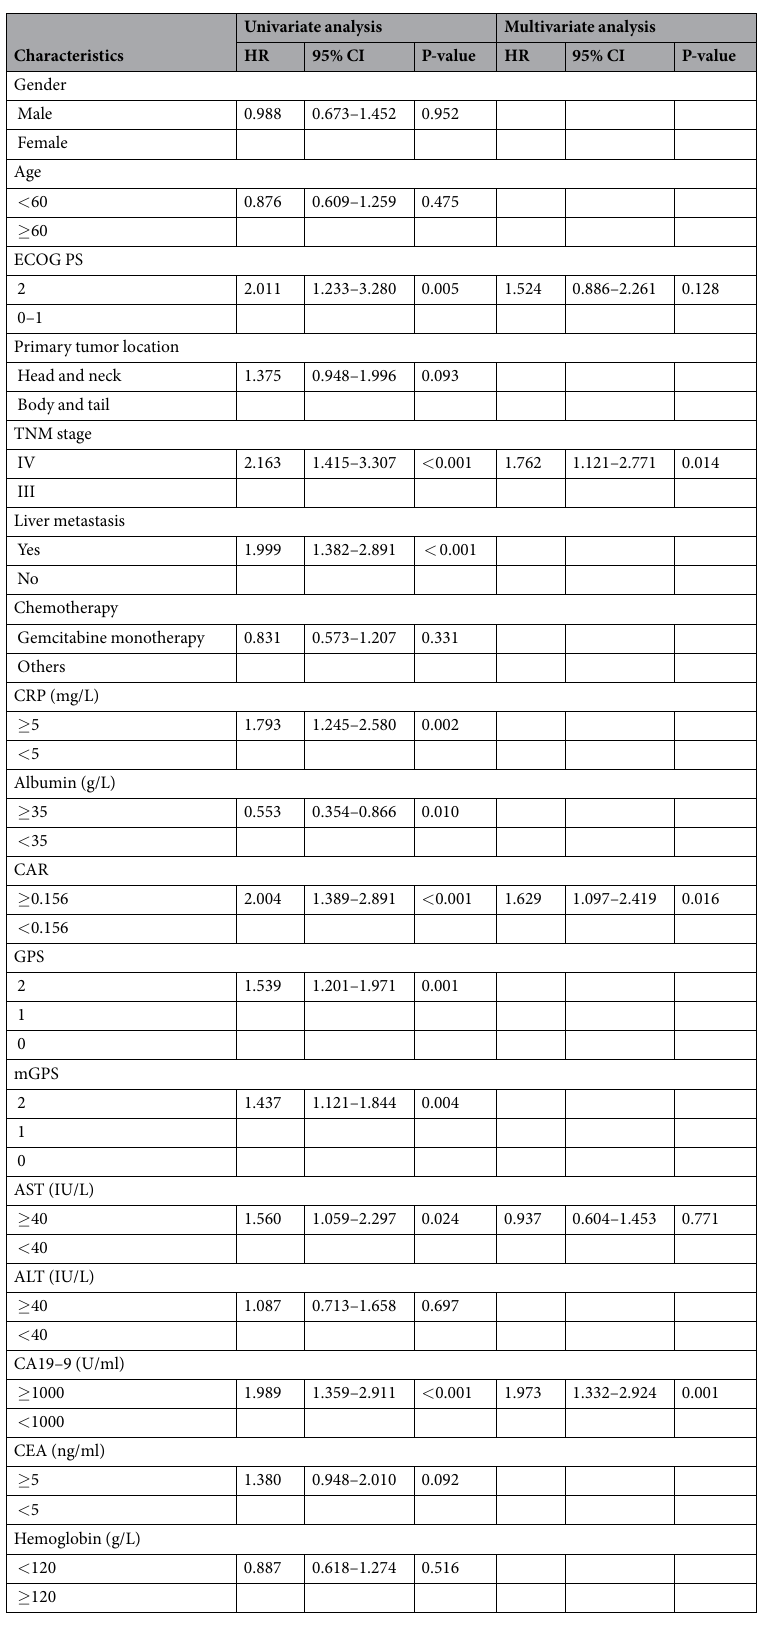
Table 3. Univariate and multivariate analysis of poor prognostic factors for OS in APC